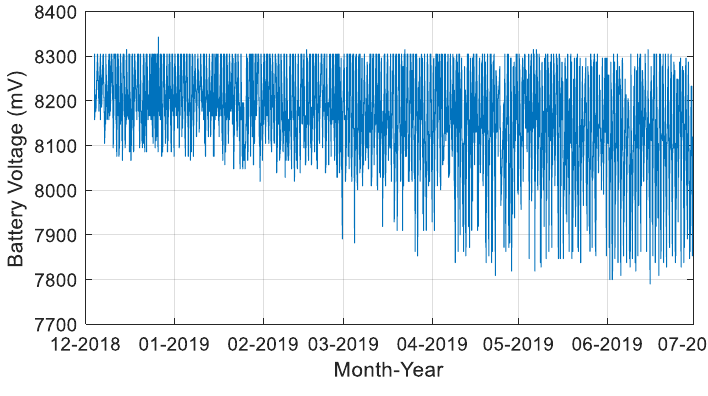
Figure 6. Battery voltage level.